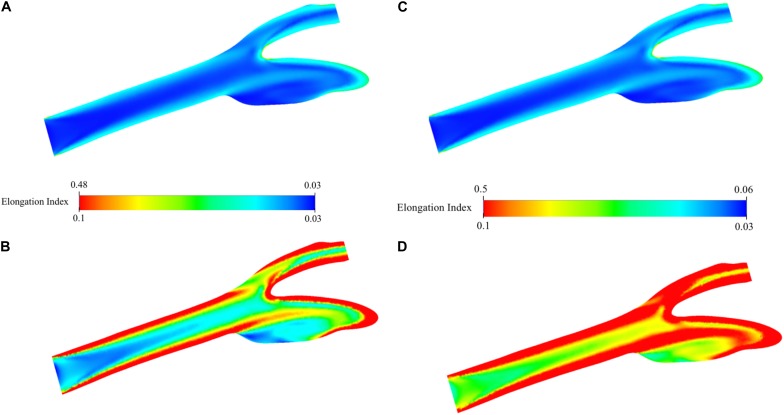
Elongation index distribution for blood flow simulation. Contours are shown on the two-dimensional midplane in the axial direction. (A) shows the range with minimum and maximum EI values while (B) shows the scaled-down range of EI values for detailed visualization for oxygenated blood. (C) shows the range with minimum and maximum EI values while (D) shows the scaled-down range of EI values for detailed visualization for deoxygenated blood.